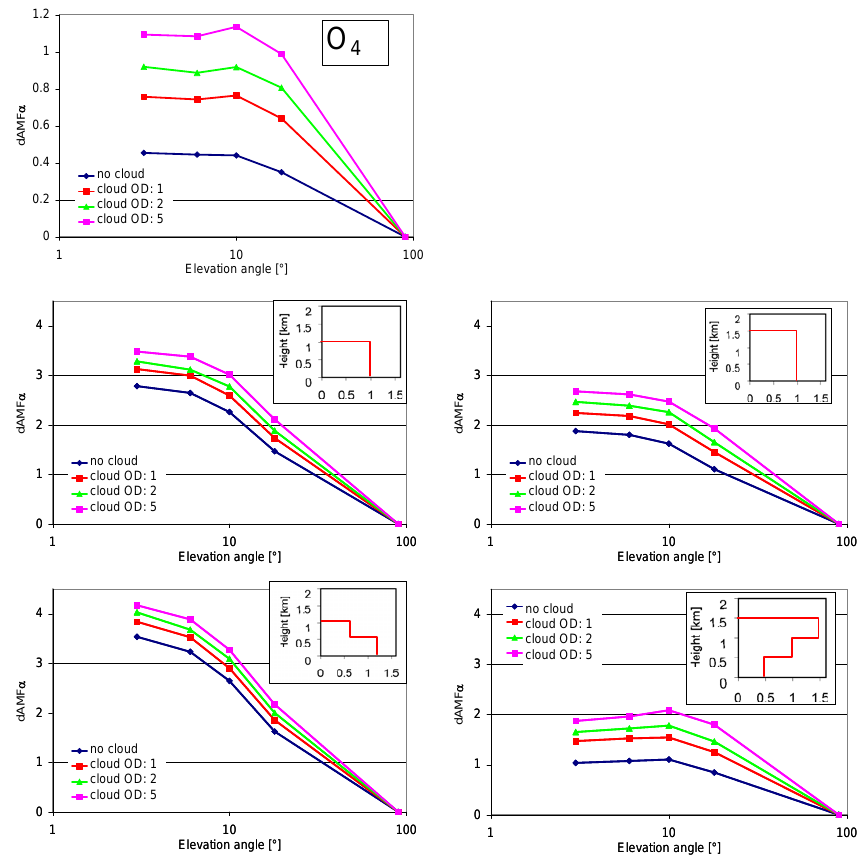
Fig. 11 Influence of a thin cloud between 4 and 5km on the measured dAMF α of O 4 (top) and trace gases with other vertical profiles on the dAMF α for different vertical profiles. Due to the “diffusing screen” effect (see Sects. 4.1.1 and 4.3) the measured dAMF α are enhanced compared to clear sky conditions. With increasing profile height, the relative increase caused by the diffusing screen effect increases (simulations for an aerosol layer between 0 and 1km with AOD of 0.5, SZA=45 ◦ and relative azimuth angle=30 ◦ ). DAMF meas the measured O 4 DAMF and DAMF clear the O 4 DAMF of the clear sky reference at the same SZA. In Fig. 13 original and normalised radiances and O 4 DAMFs for two (partly) cloudy days are presented. On 12 September 2003 thin clouds are observed in a satellite image shown in the lower part of the figure. Compared to the reference case (red lines), the observed O 4 DAMF is only weakly affected by these clouds (dark blue curves). In contrast, the observed radiance shows deviations in the late morning indicating additional scattering by cloud particles. On 9 September 2003 a spatially extended bright cloud cover is seen in the satellite image. Compared to the refer- ence values, the O 4 DAMFs are strongly increased and show rapid variations indicating strong changes of the light path length due to multiple scattering. For most of this day, the observed radiance is lower compared to the reference values indicating the presence of an optically thick